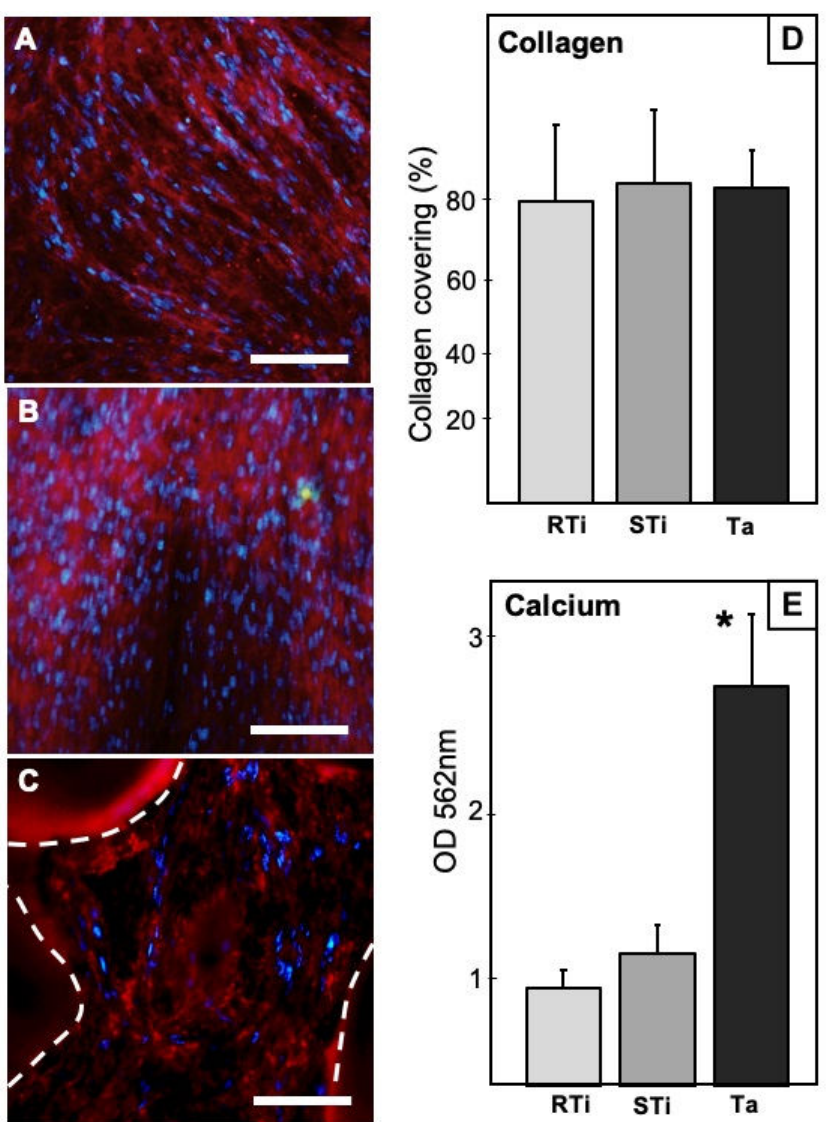
Figure 3. ( A – C ) Epifluorescence microscopy images of collagen immunostaining. RTi, STi, and Ta, respectively. Type 1 collagen fibers are stained in red. Cell nuclei are stained in blue. Dash lines on picture C indicate the area of Ta substrate in the focal plan. ( D ) Percentage of surface covered by stained collagen, as assessed by ImageJ analysis. ( E ) Calcium deposits quantification, after Red Alizarin staining. Optical density from colorimetric assays (absorbance at 562 nm). * indicates significant di ff